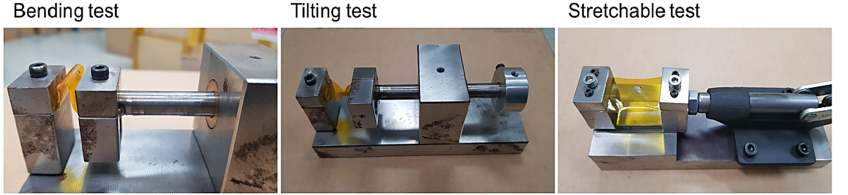
Figure 31. Digital photographs of the Au-SnO 2 -co-decorated WS 2 NS sensor upon bending, tilting, and stretching. Reproduced from [109] with the permission of Elsevier.